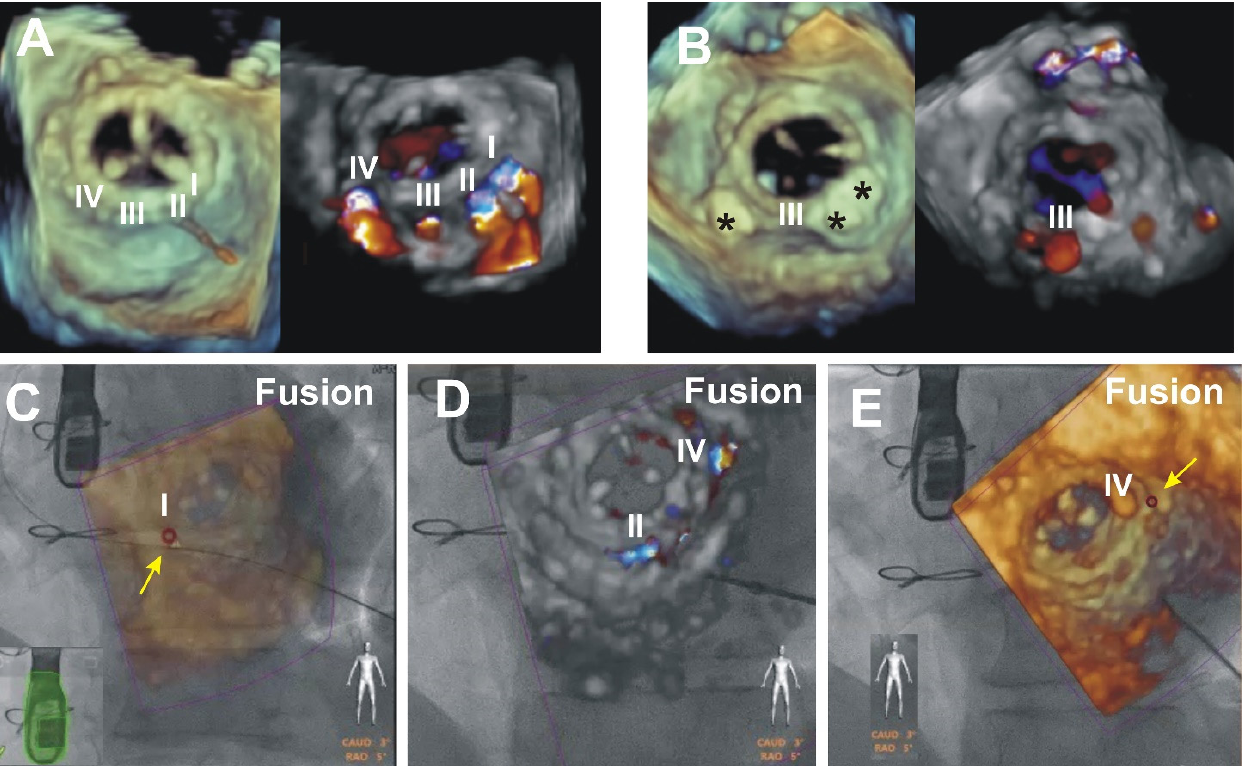
Figure 3. EFF scenario “Front view of the TEE probe”. ( A ) panel—Preprocedural 3D TEE images of the biological mitral prosthesis from the surgical perspective (left). Four (I, II, III, and IV) regurgitant jets through the PVLs seen from 4 to 8 o’clock (right). ( B ) panel—Postprocedural 3D TEE images. The occluders are marked by three black stars (left). Trace residual regurgitant jet thru the third (III) PVL is seen on 3D Color Doppler (right). ( C – E ) panels—intraprocedural merged 3D TEE and fluoroscopy images with wire passage thru the I ( C panel), II ( D panel) and IV ( E panel) PVLs. The position of the C-arm is at 3° Caud and 5° RAO, producing a front view of the TEE probe. ( C ) panel—EFF with reduced brightness of the 3D TEE for the optimal view of the wire on the fluoroscopy. ( D ) panel—application of 3D Color Doppler for the second (II) and the fourth (IV) defects. The arrows point to the anatomical markers (red circle) applied at the locations of the first (I) and fourth (IV) PVLs ( C , E ).